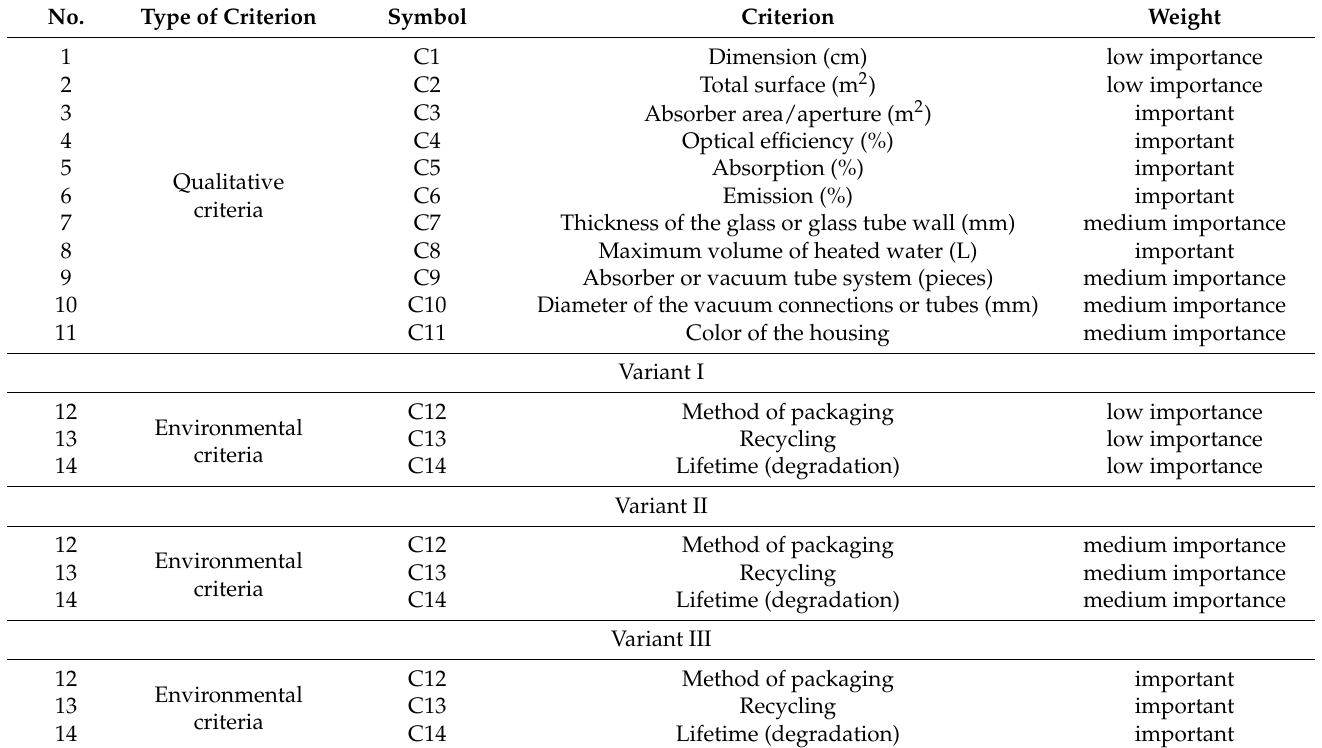
Table 2. Importance of criteria for